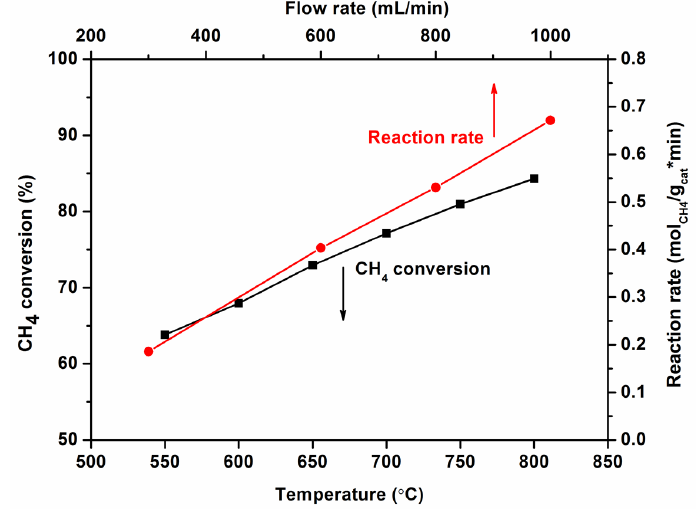
Figure14. CatalyticperformanceoftheC30catalystduringthePOMchangingwithoperationtemperature Figure 14. Catalytic performance of the C30 catalyst during the POM changing with operation